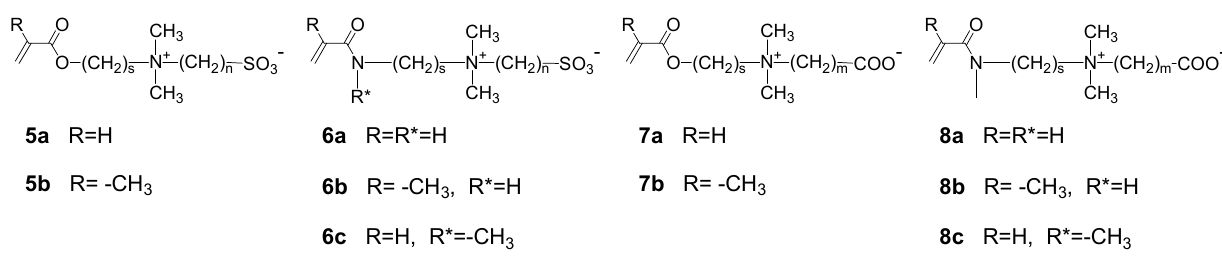
Figure 3. Frequently reported aliphatic zwitterionic (meth)acrylic monomers, with s  2, n = 2–11, m =